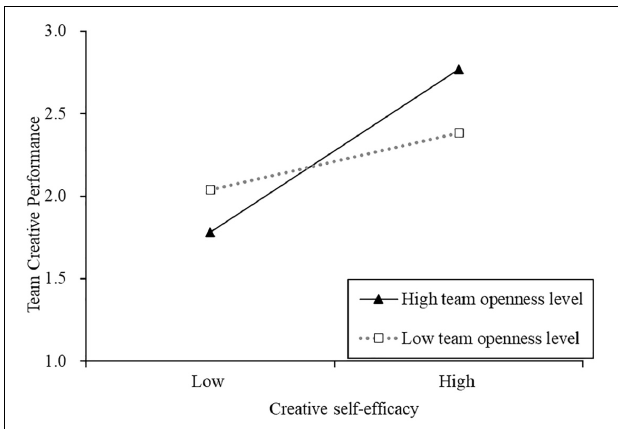
FIGURE 2 | Team-mean-level openness—creative self-efficacy interaction for team creative performance.